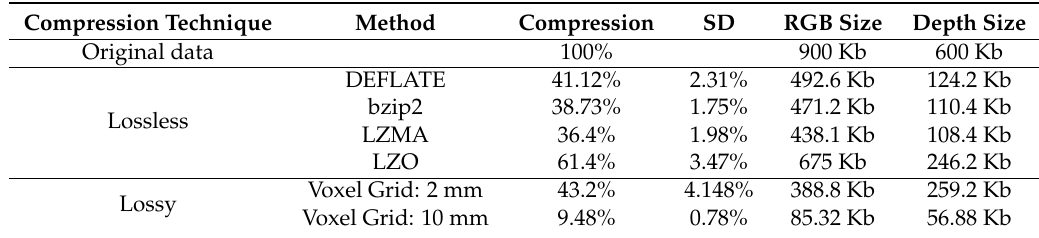
Table 1. Compression